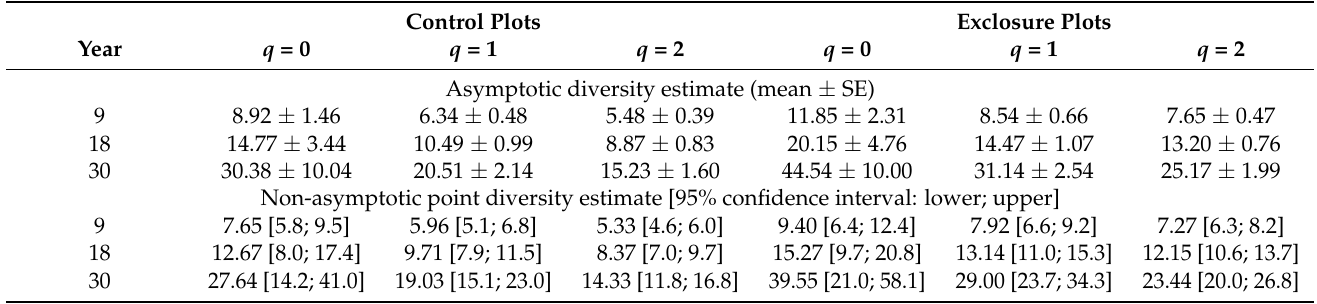
Table 5. Asymptotic and non-asymptotic diversity estimates for incidence-based tree height class data collected on control and exclosure plots in Austria 9, 18, and 30 years after establishment of study plots. Non-asymptotic rarefaction and extrapolation analyses are based on point diversities for a specified sample coverage of C max = 96.4%. Numerical values for Hill numbers of order q ( q = 0, height class richness; q = 1, Shannon diversity; q = 2, Simpson diversity).